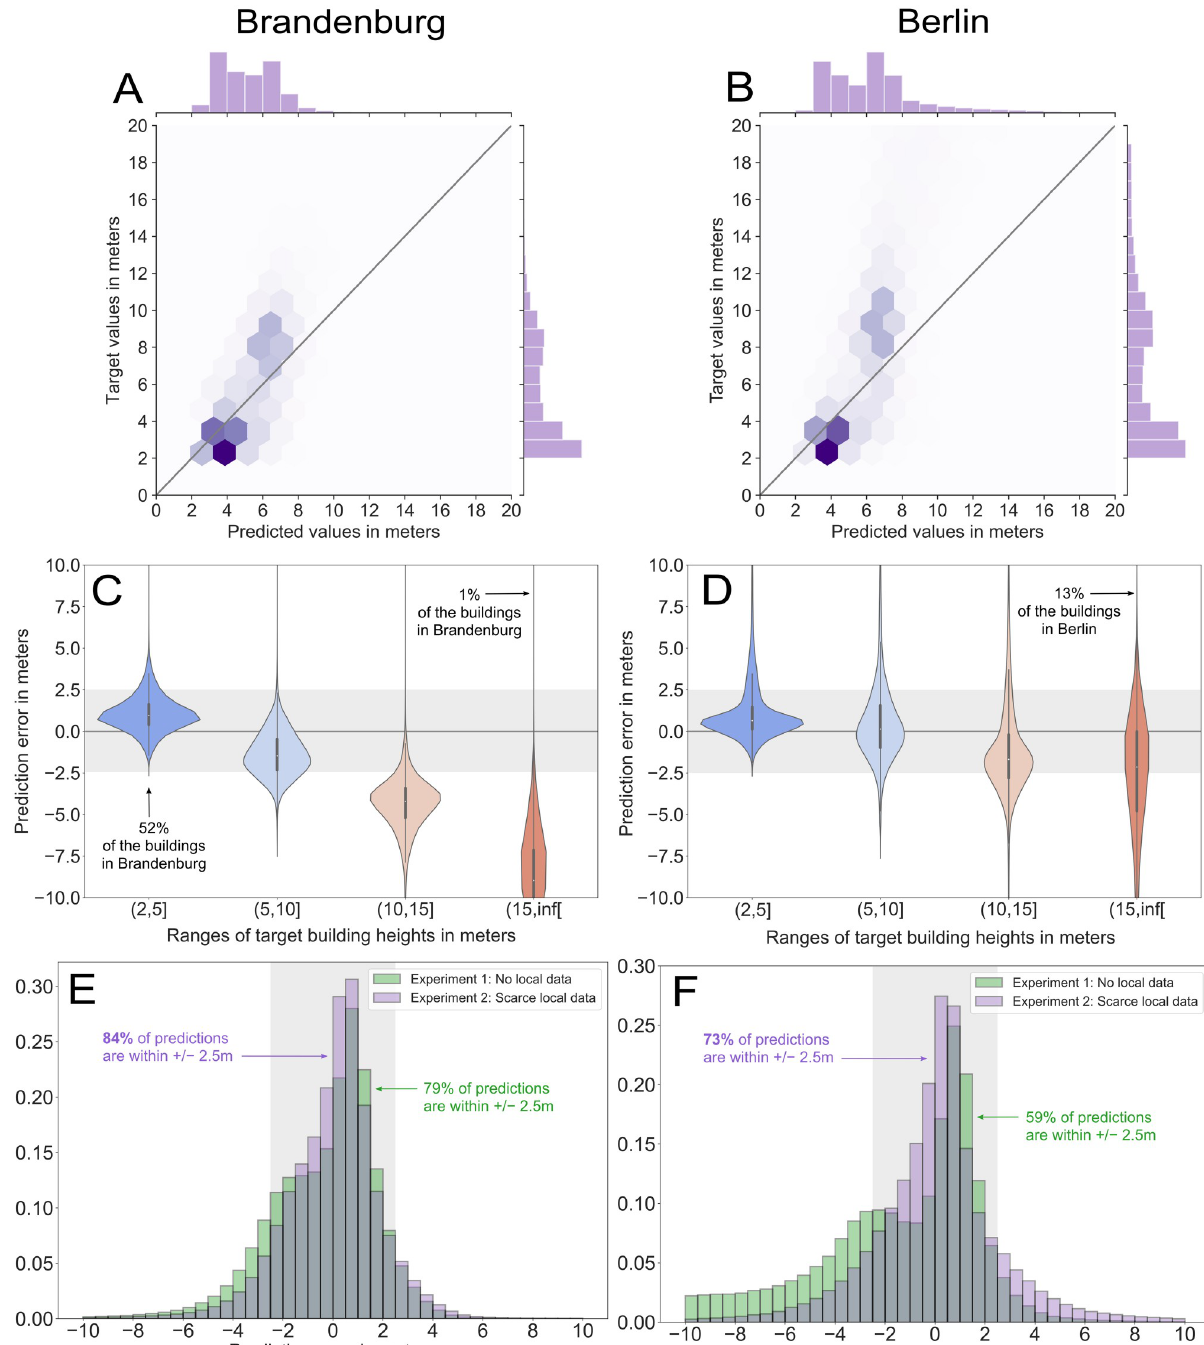
Fig 4. Results of the predictions for the test regions, Brandenburg ( left ) and Berlin ( right ). (A–B) Joint plot of predicted values over target values for Experiment 1 (No local data), both in meters, with the marginal distributions as barplots. The intensity of the bins’ color represent the density of data points in the bin. On the thick diagonal grey line, points are perfectly predicted. Points above the line are under-predicted and those below the line are over-predicted. (C–D) Error distribution of different target height ranges, for Experiment 1 in Brandenburg and for Experiment 2 (2% local sample) in Berlin. The shaded areas represents an error range of +/ − 2.5 meters, which roughly corresponds to the height of one floor. (E–F) Error distributions for Experiments 1 and 2 . The shaded areas represents an error range of +/ − 2.5